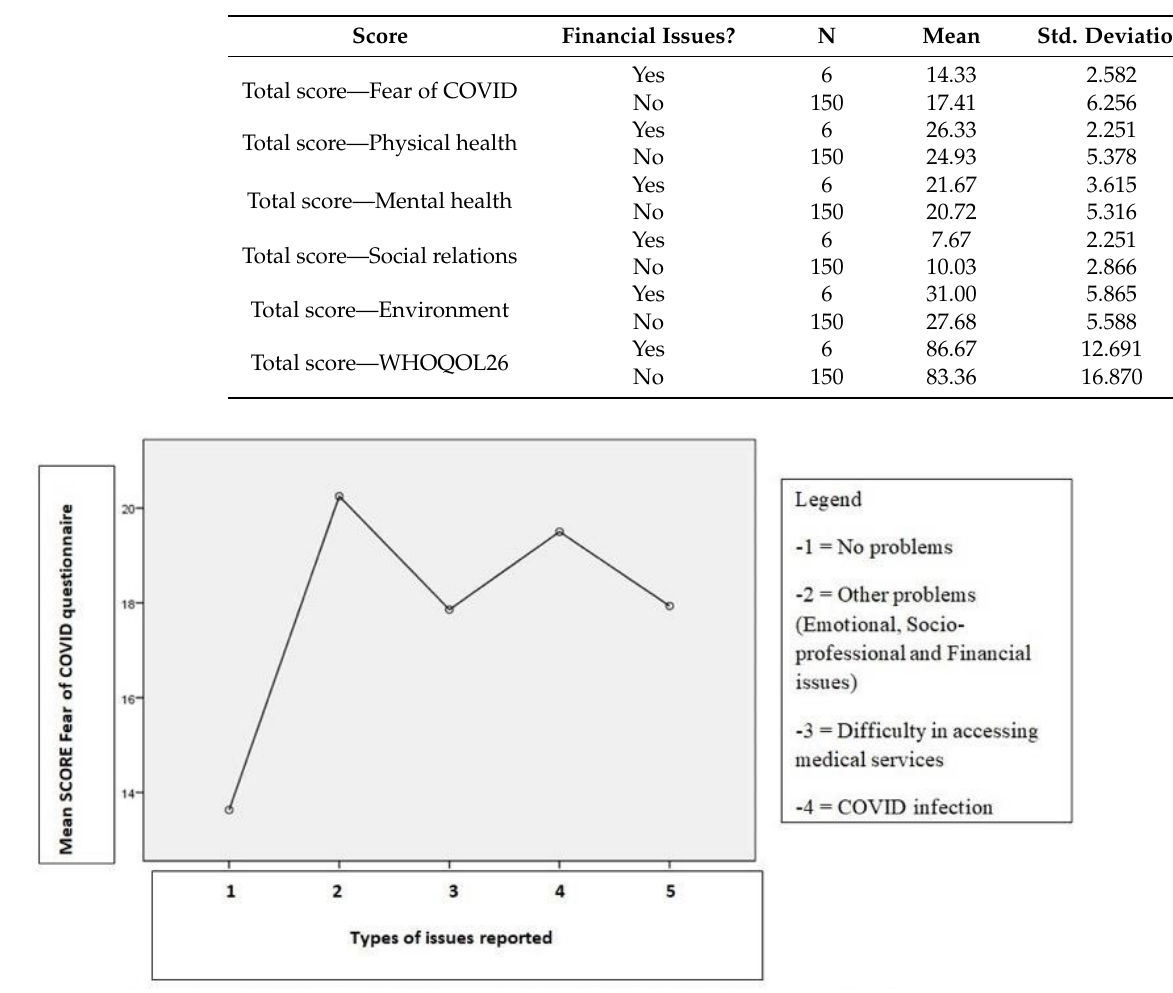
Table 6. Cross-reference between the total scores of participants reporting financial issues.